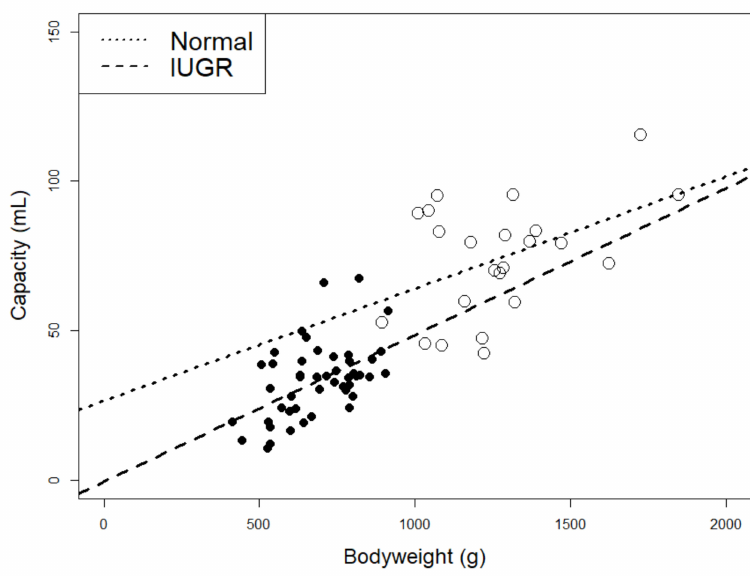
Figure 1. Data plotted against each other, normal piglets (white) and IUGR piglets (black). Linear regression trend lines were made for normal piglets (dotted) and IUGR piglets (broken line).